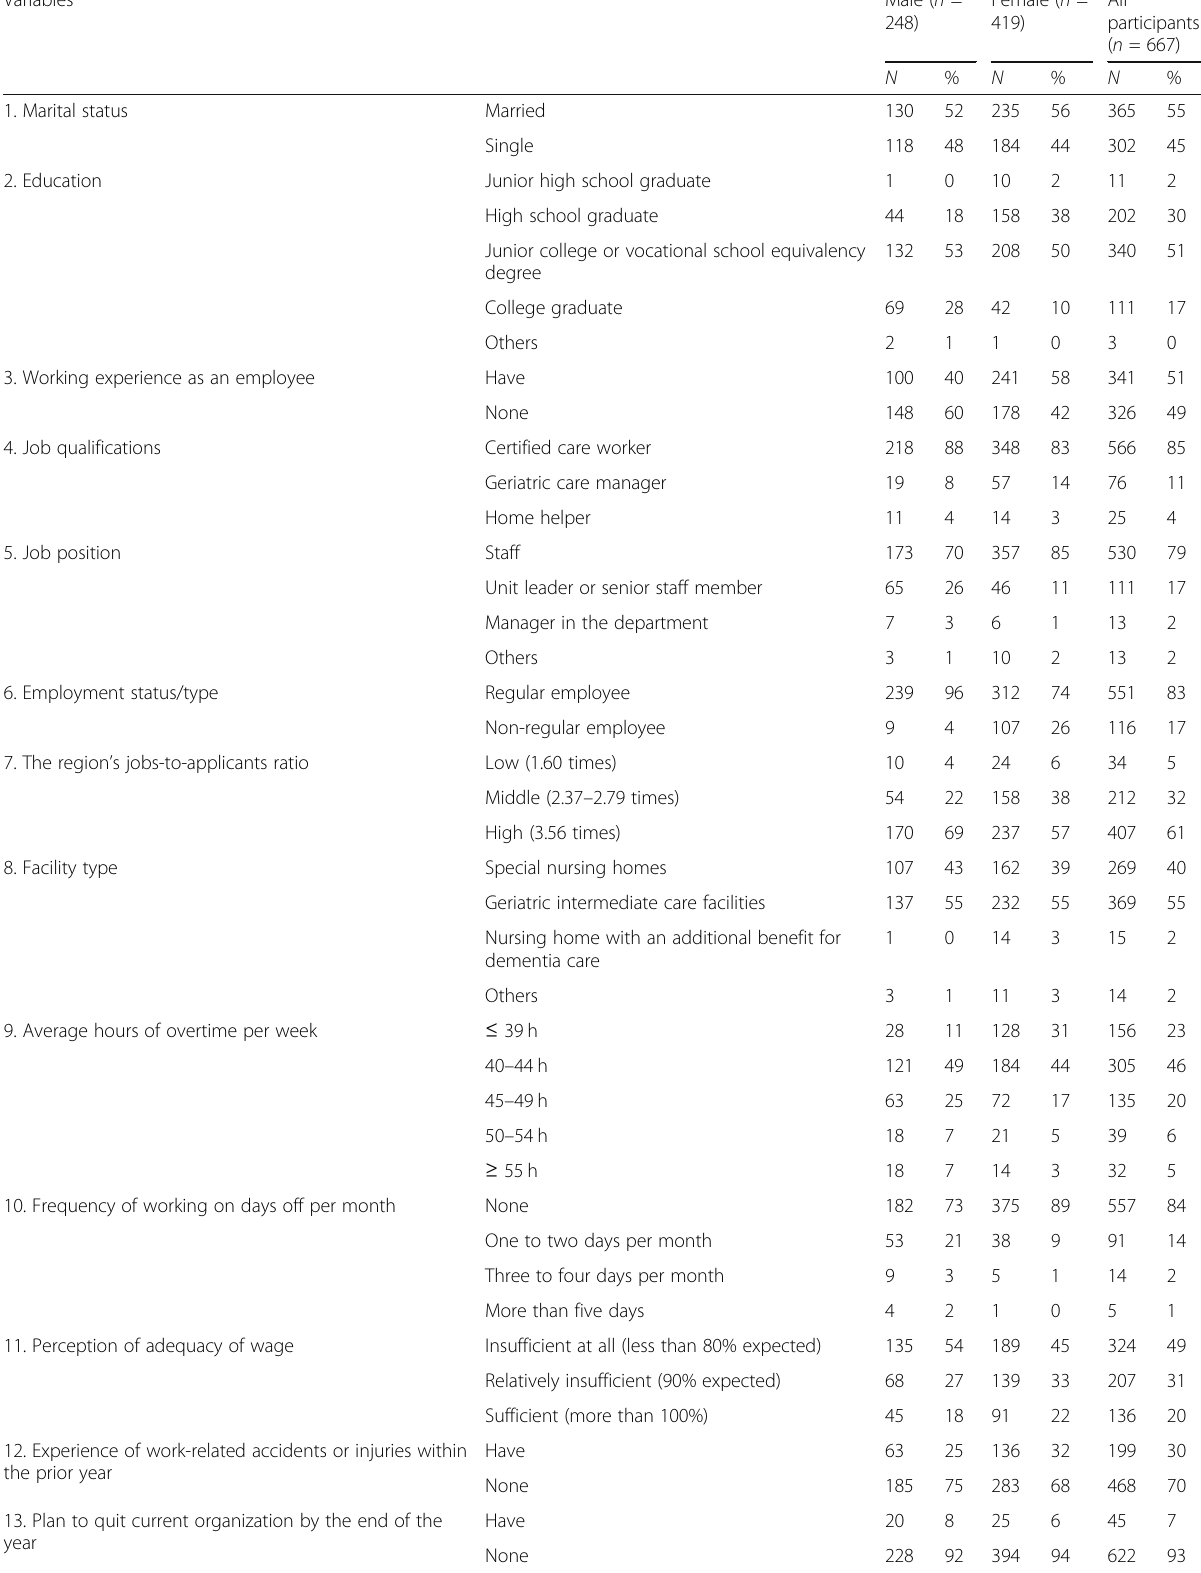
Table 1 Basic attributes and characteristics of study participants ( N = 667) a.